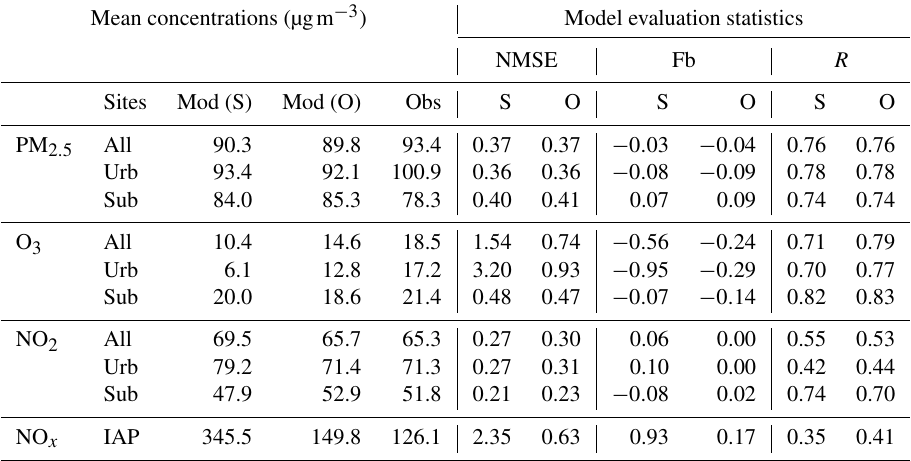
Table 4. Statistical evaluation of modelled pollutant concentrations for the campaign period, using MEIC Std (S) and MEIC Opt (O) emis- sions inventories. Mean modelled (Mod) and observed (Obs) concentrations and statistics divided into all (12 monitoring network sites and the IAP field site for NO 2 and O 3 , monitoring network sites only for PM 2 . 5 ) and urban and suburban monitoring site groups. Urban and suburban sites defined in Table 1. NO x measurements only available at the IAP field site. Mean concentrations and statistics calculated from matching hourly